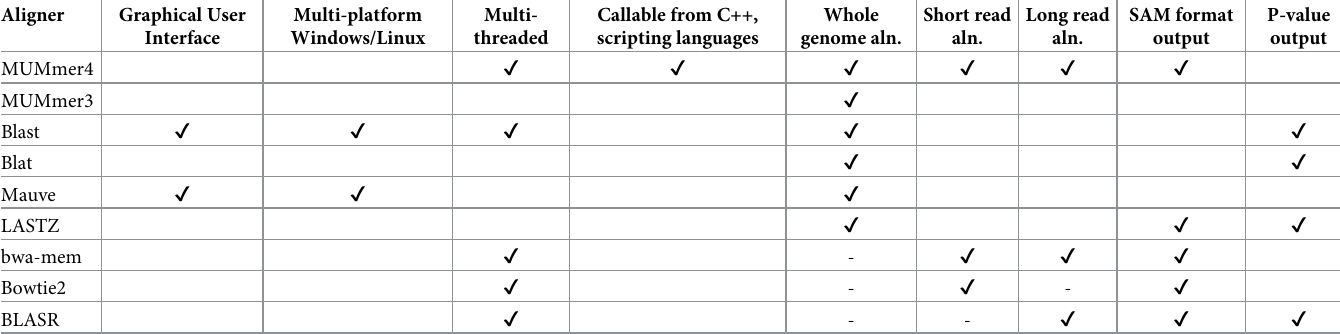
Table 1. Comparison of aligner features. A checkmark means the feature is present and usable, otherwise the feature is absent or its use is impractical. Features that are absent by design are marked with a dash.